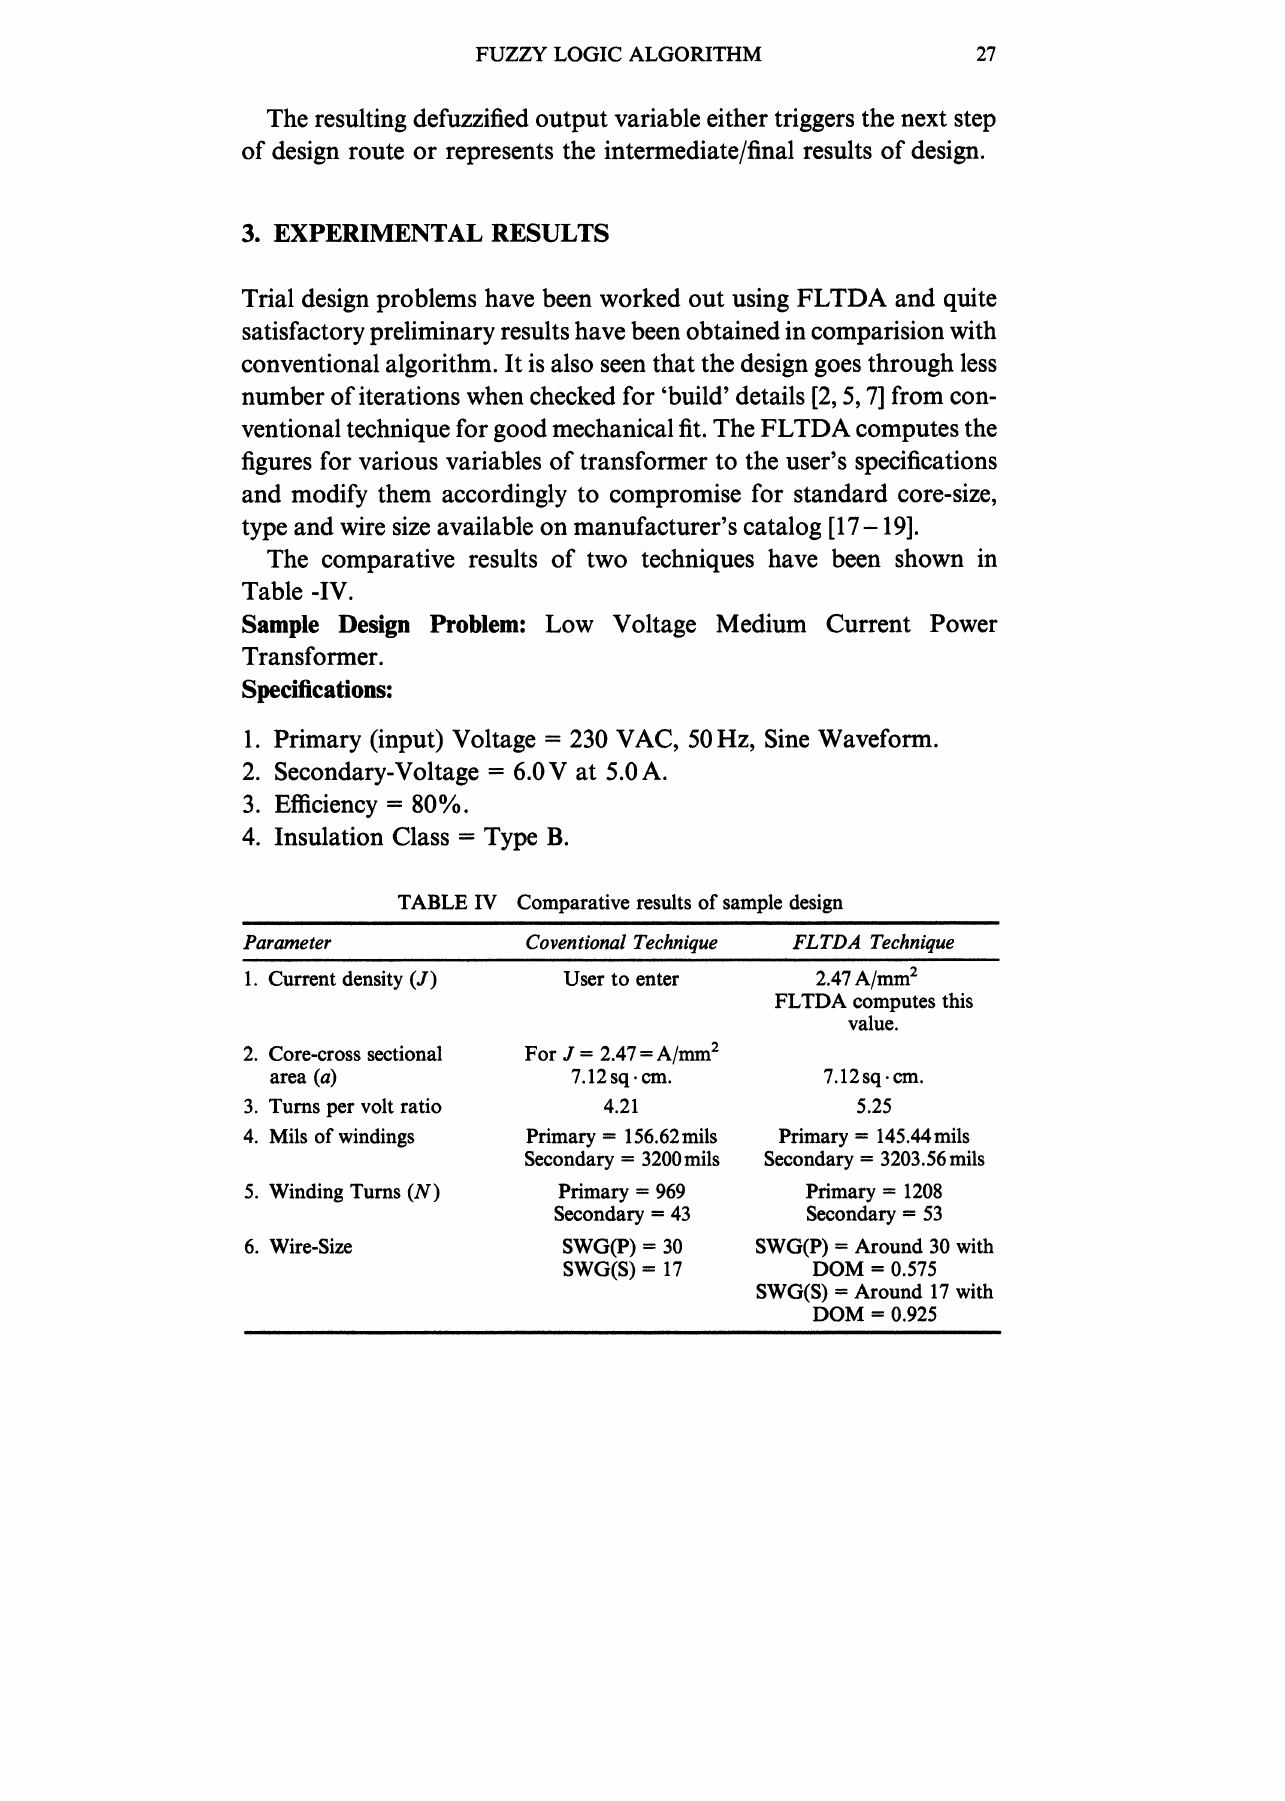
Sample Design Problem: Low Voltage Medium Current Power Transformer.